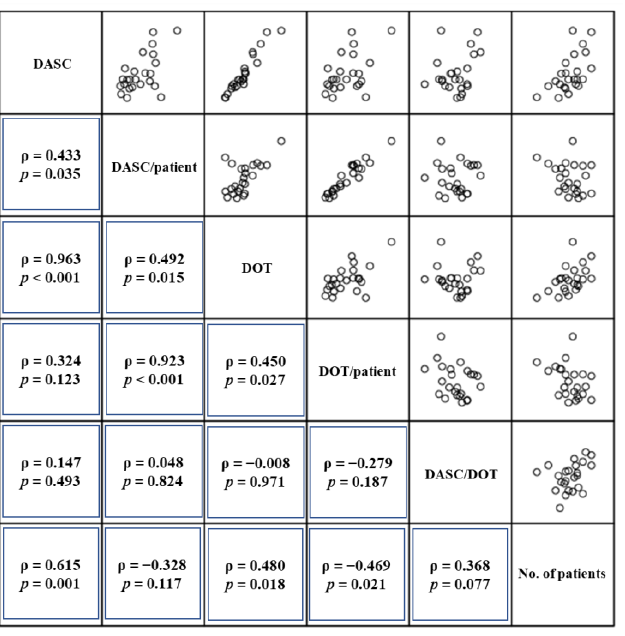
Figure 4. The scatterplot among DASC, DASC/patient, DOT, DOT/patient, DASC/DOT, and the number of patients per month. The x - and y -axes indicate each metric, while the plots indicate each month’s observed values. Diagonal cells show Spearman’s correlation analysis results. A strong cor- relation was observed between DASC and DOT (ρ = 0.963) as well as DASC/patient and DOT/patient (ρ = 0.923). In contrast, DASC/DOT had no correlation with other metrics (ρ = −0.279–0.368). DASC, days of antibiotic spectrum coverage; DOT, days of therapy.